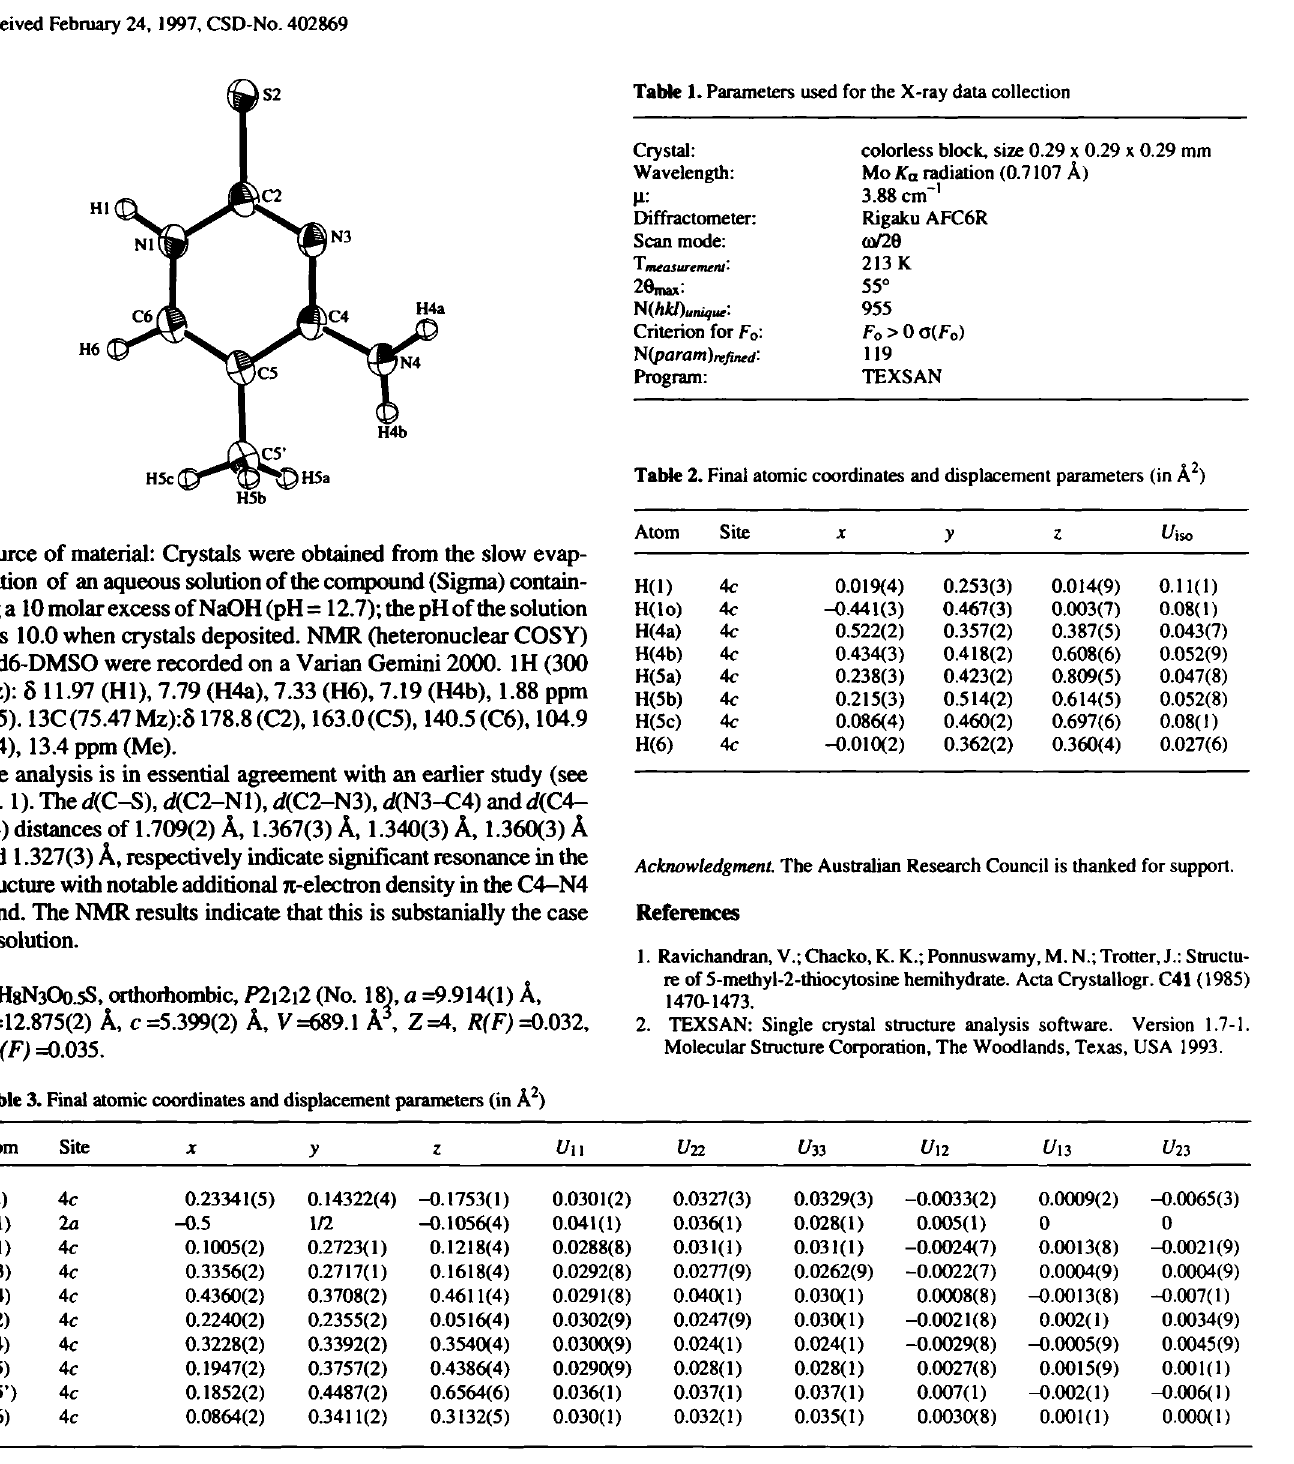
Table 3. Final atomic coordinates and displacement parameters (in h?)